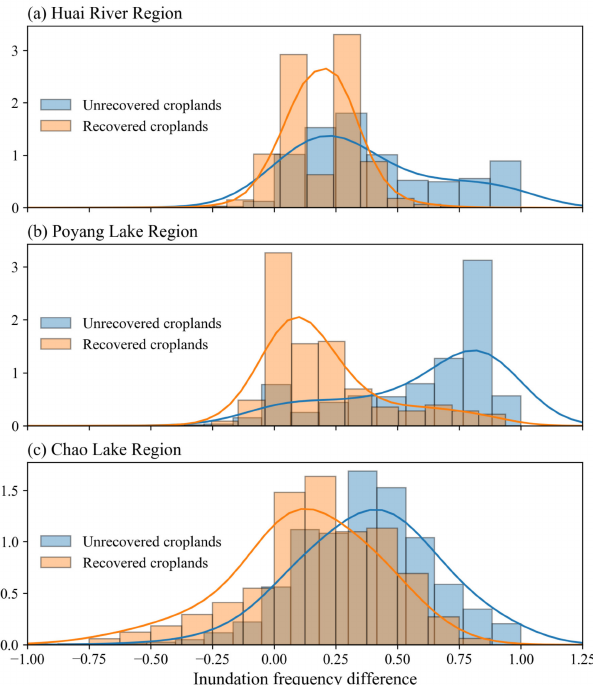
Figure 12. Probability density function (PDF) plots show differences between the inundation fre- quency three months after the flood peaks in 2020 and that of the same period in 2019: ( a ) the Huai River Region; ( b ) the Poyang Lake Region; ( c ) the Chao Lake Region. The PDF plots were generated using 2500 points within the recovered croplands and 2500 points within the unrecovered croplands by stratified random